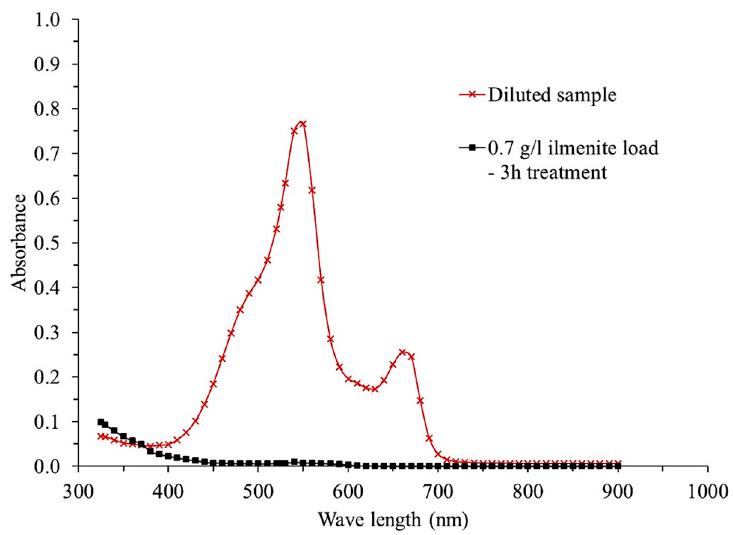
Figure 10. Spectral scan of the diluted wastewater solution before and after the photocatalytic reac- tion.